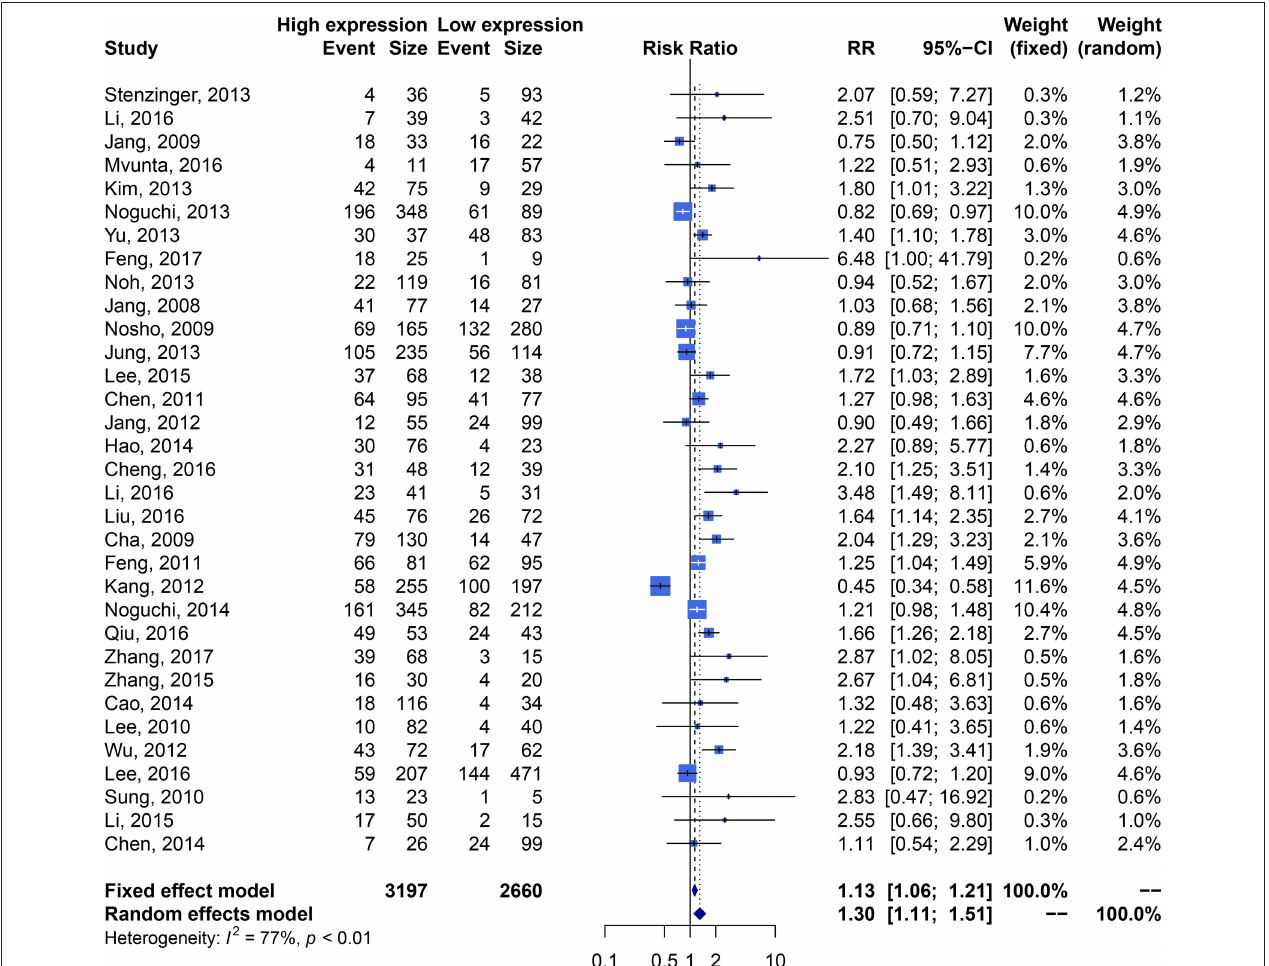
FIGURE 4 | Forest plots of tumor stage compared SIRT1 overexpression with underexpression.